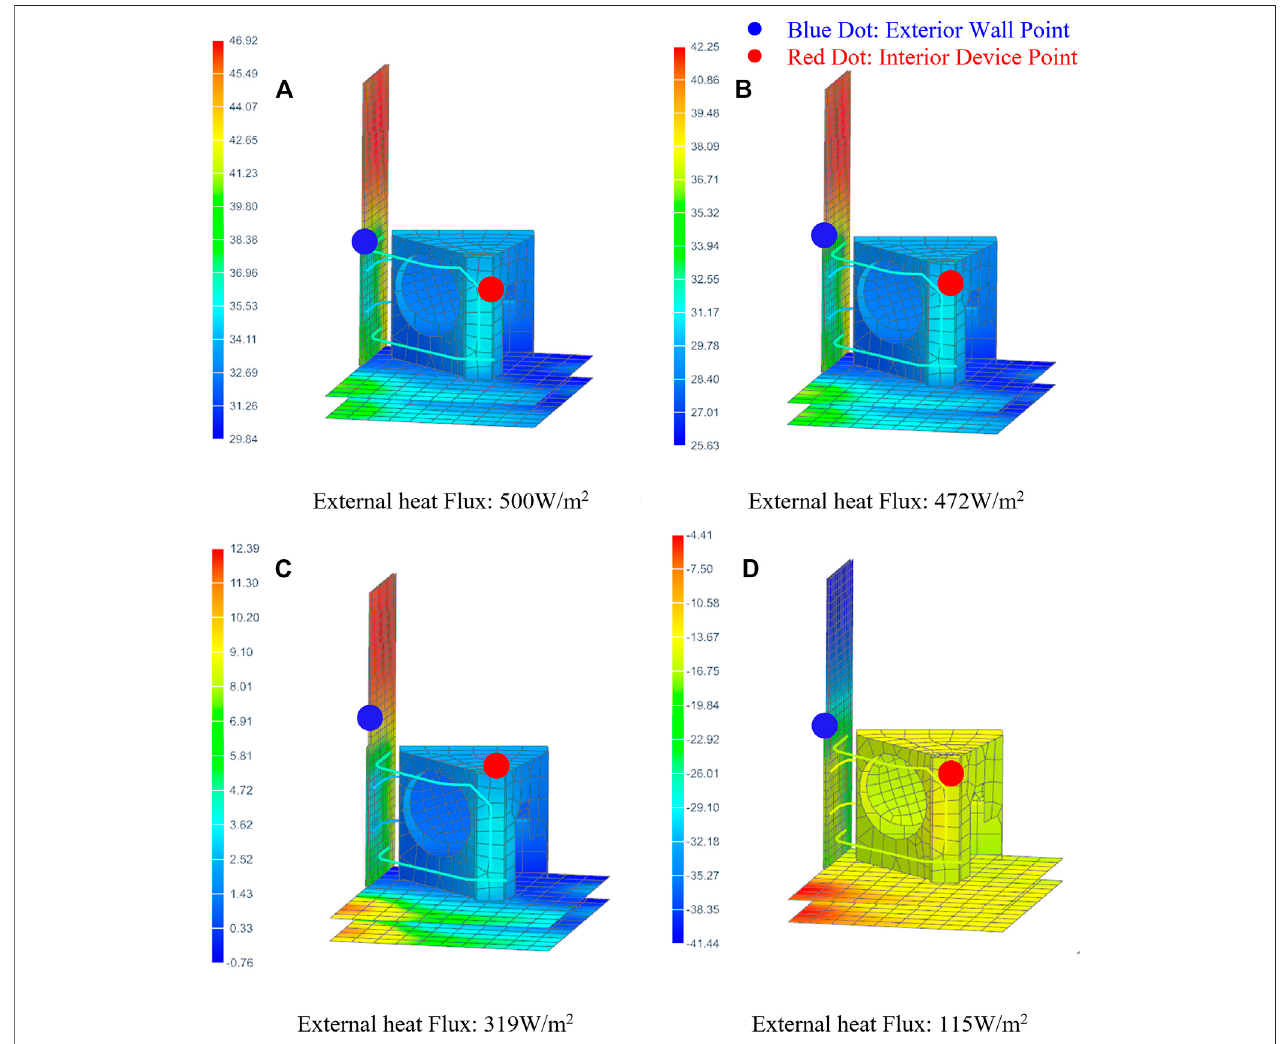
FIGURE 10 | Temperature contours of the interior device under different external heat fl ux. A-D show the temperatures at different heat fl uxes.